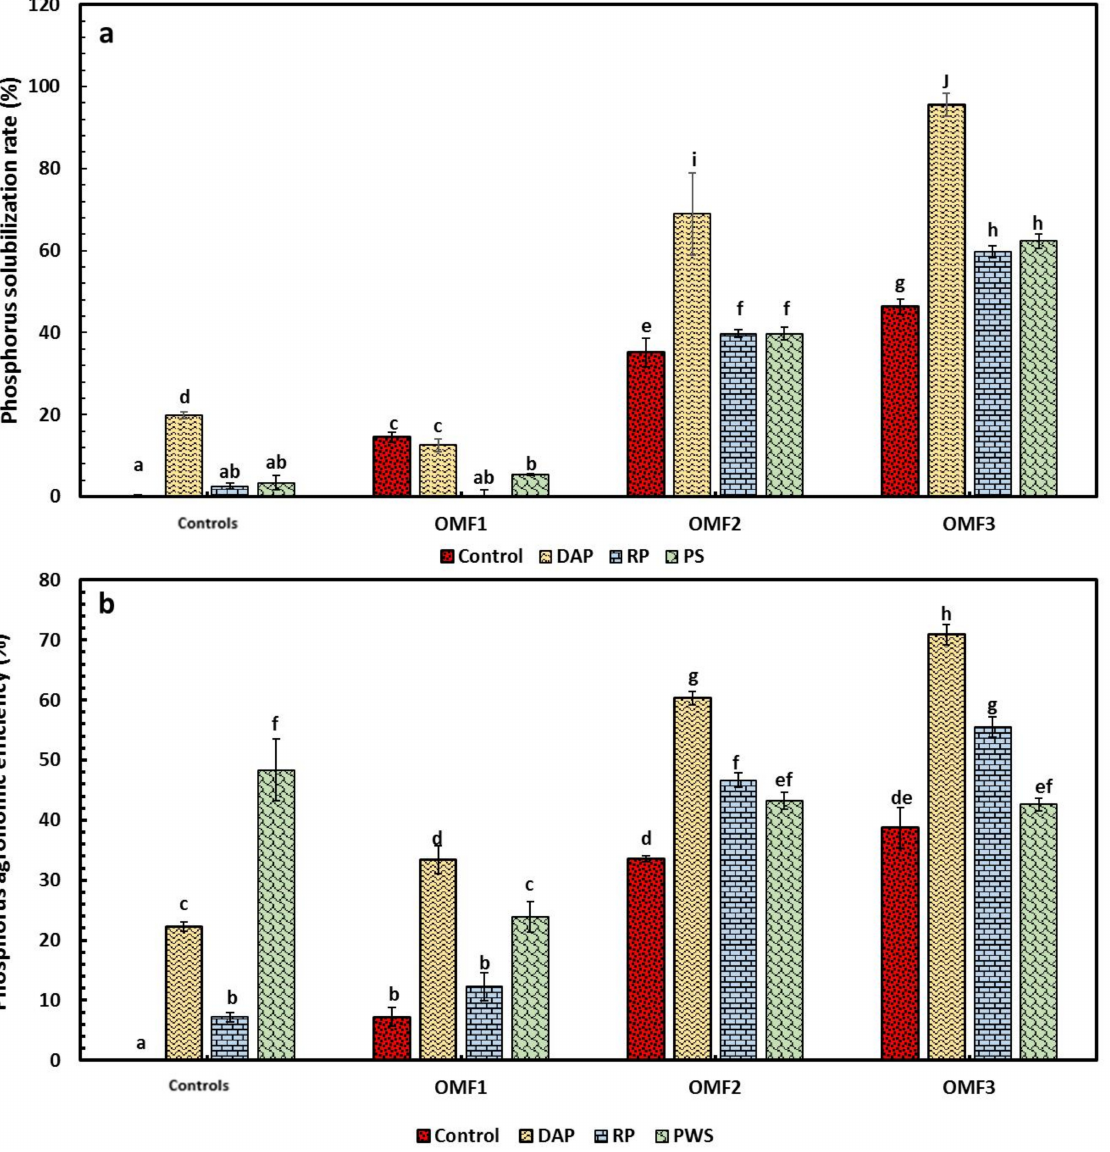
Figure 1. Effect of organo-mineral application formulations on phosphorus solubilization rate (%) ( a ) and phosphorus agronomic efficiency ( b ). OMF0 = without compost, OMF1 = 10 t/ha of compost, OMF2 = 50 t/ha of compost, OMF3 = 100 t/ha of compost, RP = rock phosphate, PWS = phosphate sludge. Results represent the means ( ± standard deviation) of five replicates. Different letters are significantly different according to Tukey’s test at p <